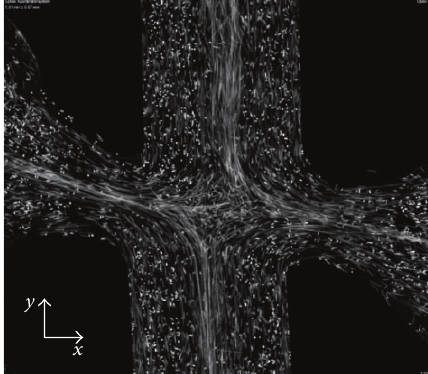
Figure 21: CT picture of the weld of PP-LGF30 with initial fiber orientation being longitudinal to the joining direction (DP I).